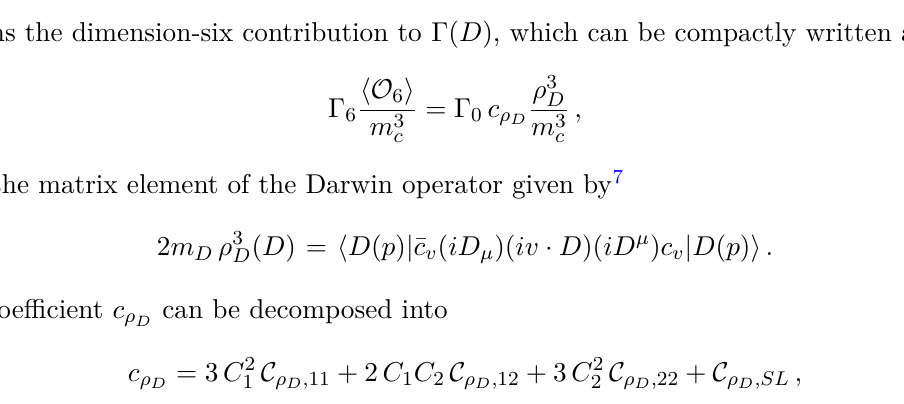
at LO and “NLO”, setting for reference m 1